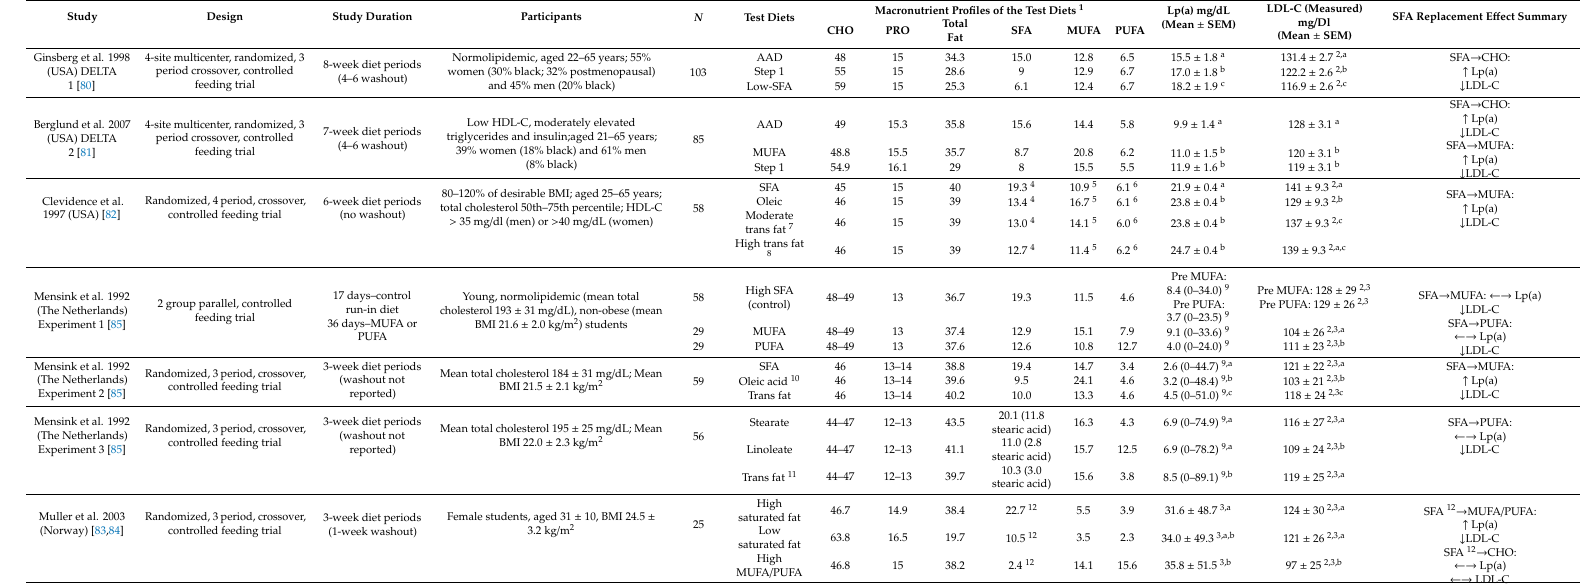
Table 1. The e ff ect of replacing saturated fat with other macronutrients on Lp(a) and low-density lipoprotein cholesterol